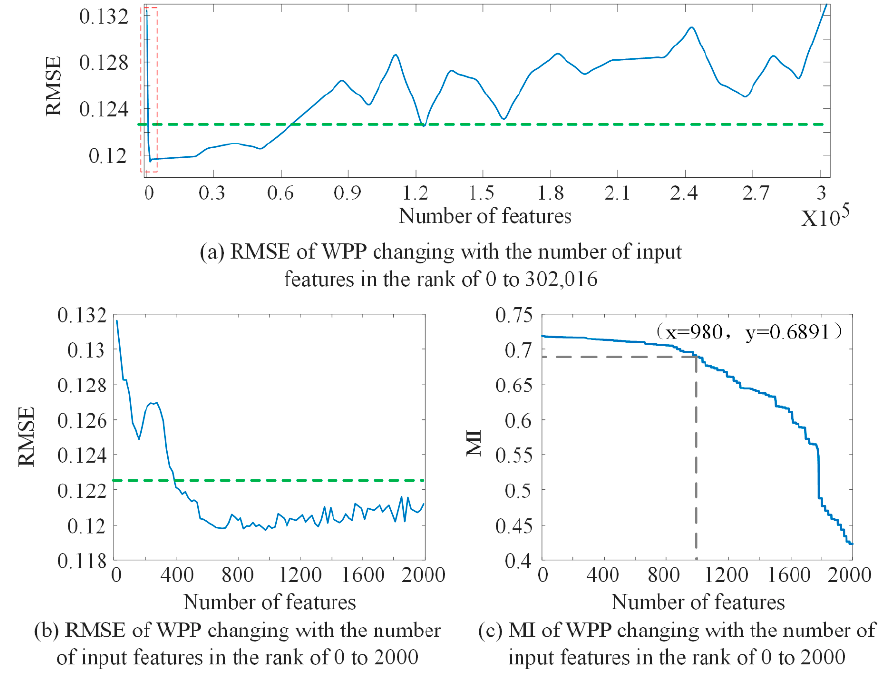
Figure 8. The curve graph of the wind power prediction (WPP) accuracy as a function of the number of input features.